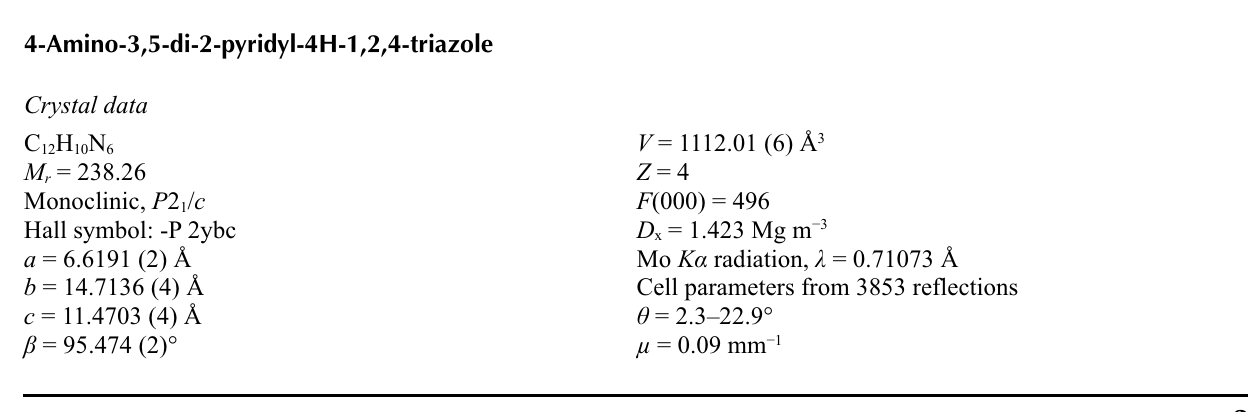
Packing diagram of the title compound, showing the N—H···N intramolecular hydrogen bonds and the C—H··· π intermolecular interactions as dashed lines. The green dot represents the centroid of the N6—C8—C9—C10—C11—C12